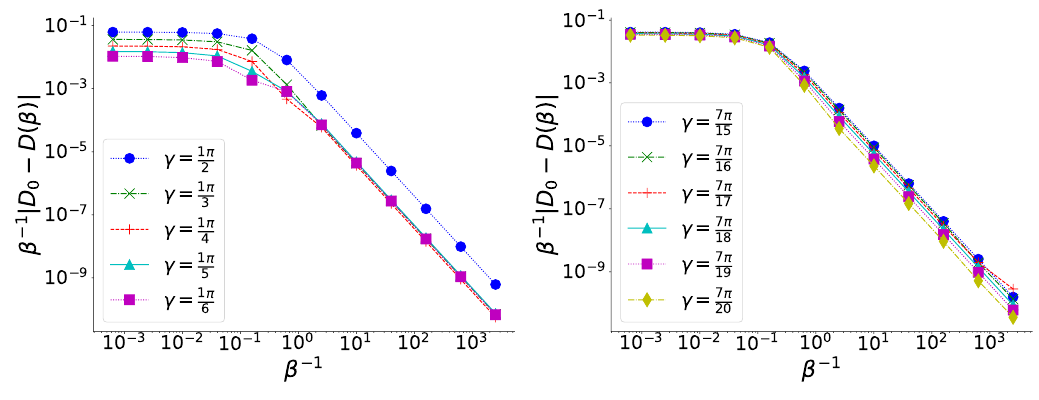
of (10) and the 0 | ∼ β 3 at high temperatures 0